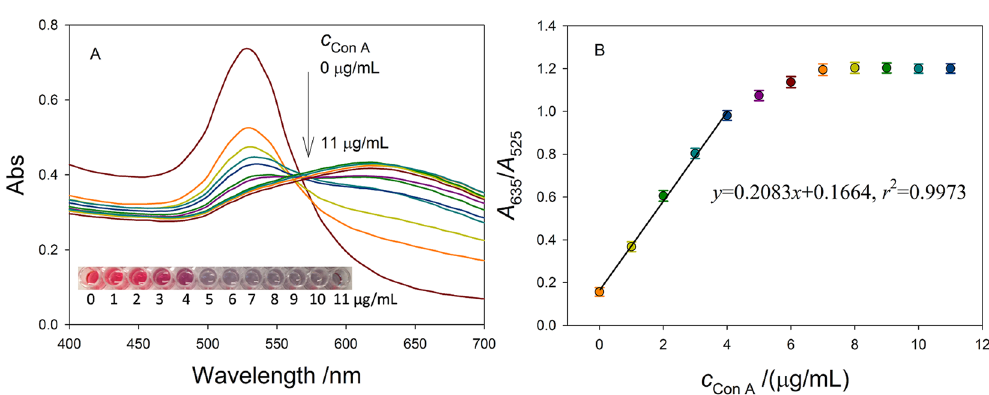
Figure 3. ( A ) UV-vis spectra of dextran@AuNPs mixed with different concentration of Con A, 0, 1, 2, 3, 4, 5, 6, 7, 8, 9, 10, 11 μ g/mL. ( B ) The absorption ratio in 635 nm and 525 nm for the concentration of Con